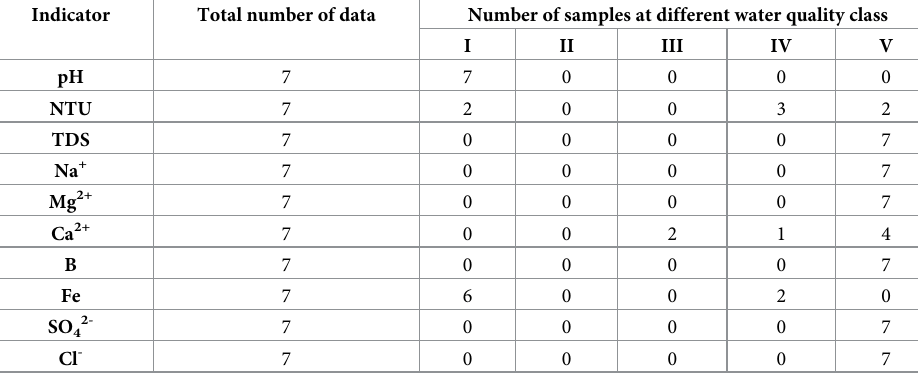
Table 8. Environmental quality of seven groundwater samples from the salt marsh area. Indicator